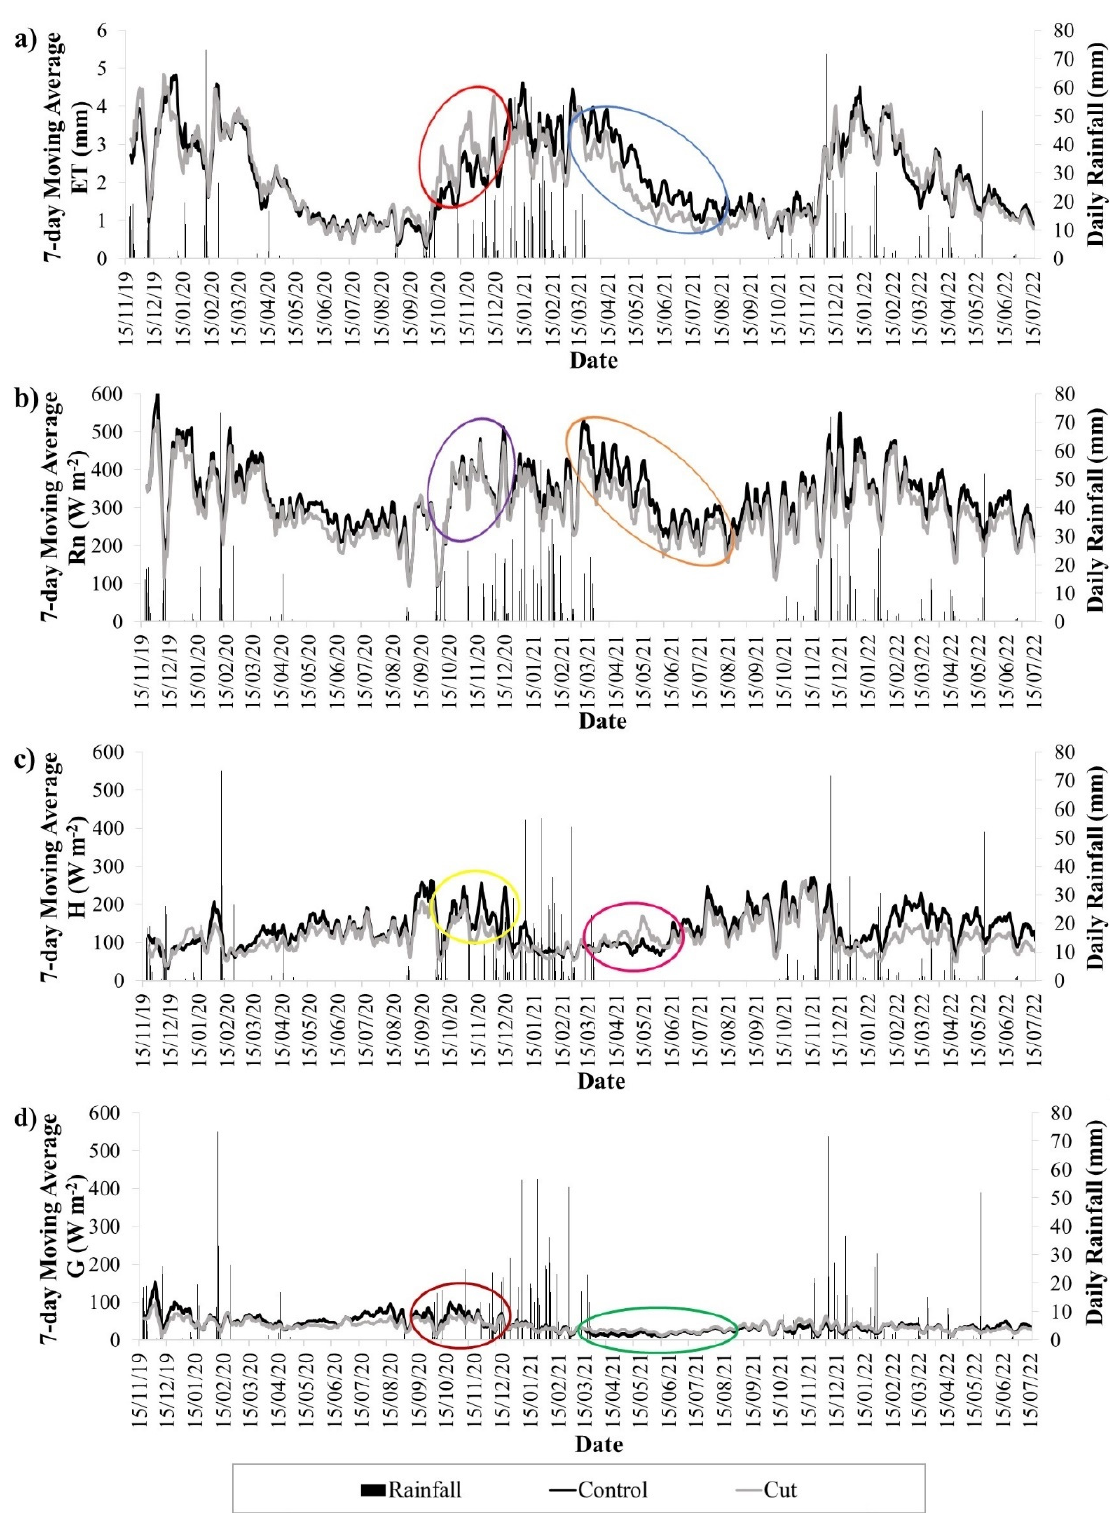
Figure 8 . 7-Day moving averages for ( a ) ET, ( b ) Rn, ( c ) H and ( d ) G during unstable conditions at the control and cut plots, and the daily rainfall for the measurement period.